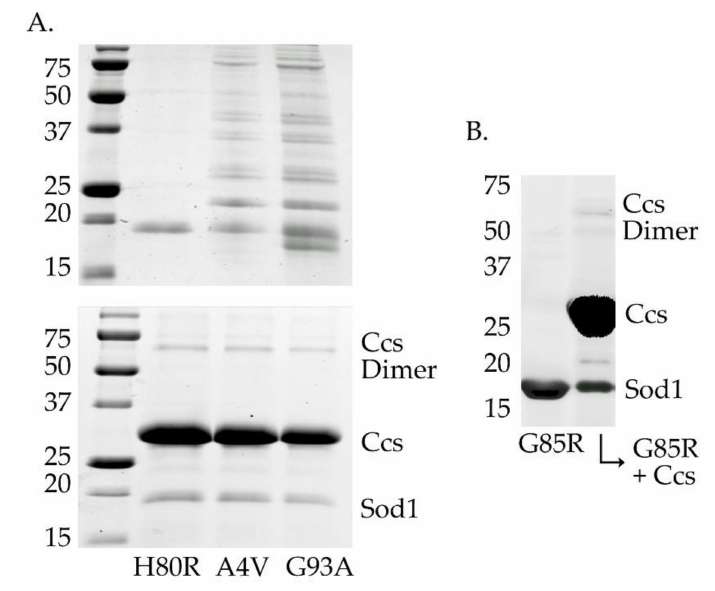
Figure 4. Stabilization of fALS-Sod1 mutants by Ccs. The top gel in panel A (the left two gels) compares the stability of two WTL mutants with the metal-binding-region mutant H80R (and G85R in panel B (right gel), lane 1), after 4 days at 4 ◦ C. The WTL mutants are highly oligomerized (A4V and G93A lanes) as compared to the two MBR mutants. The bottom gel in panel A shows that the same WTL proteins are protected from severe oligomerization if incubated as a complex with an apo (metal-free) form of Ccs. The complexes shown here are between human Sod1 and human